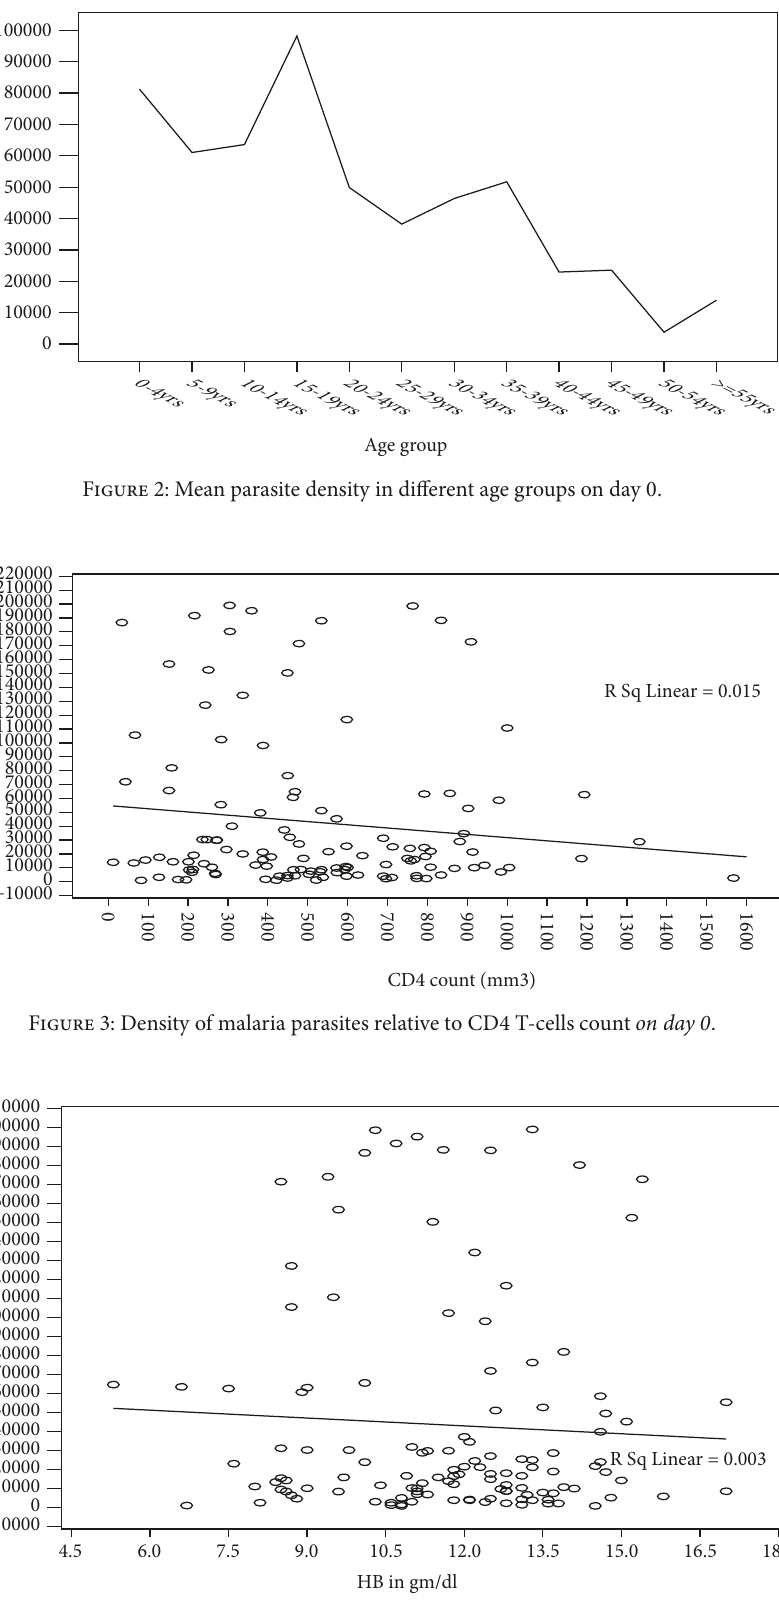
Figure 4: Haemoglobin and parasite density prior to antimalarial